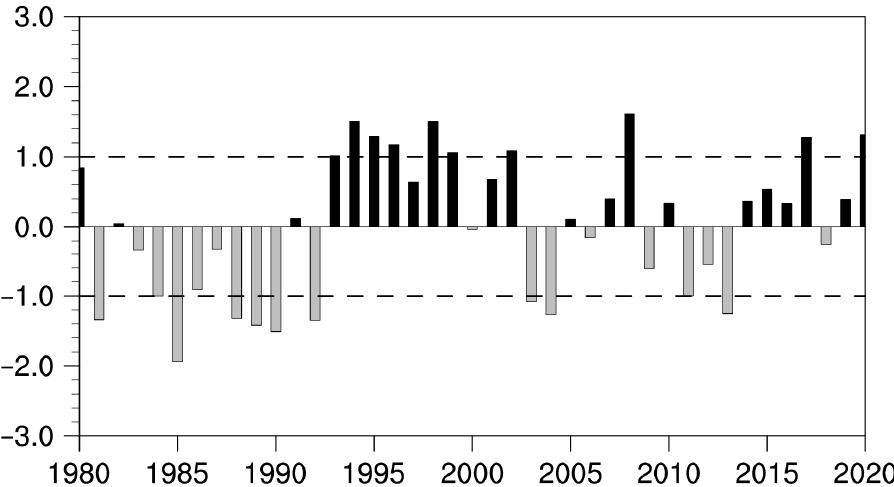
Figure 2. The normalized time series of the 206-station regional mean total summer precipitation in southern China from 1980 to 2020.